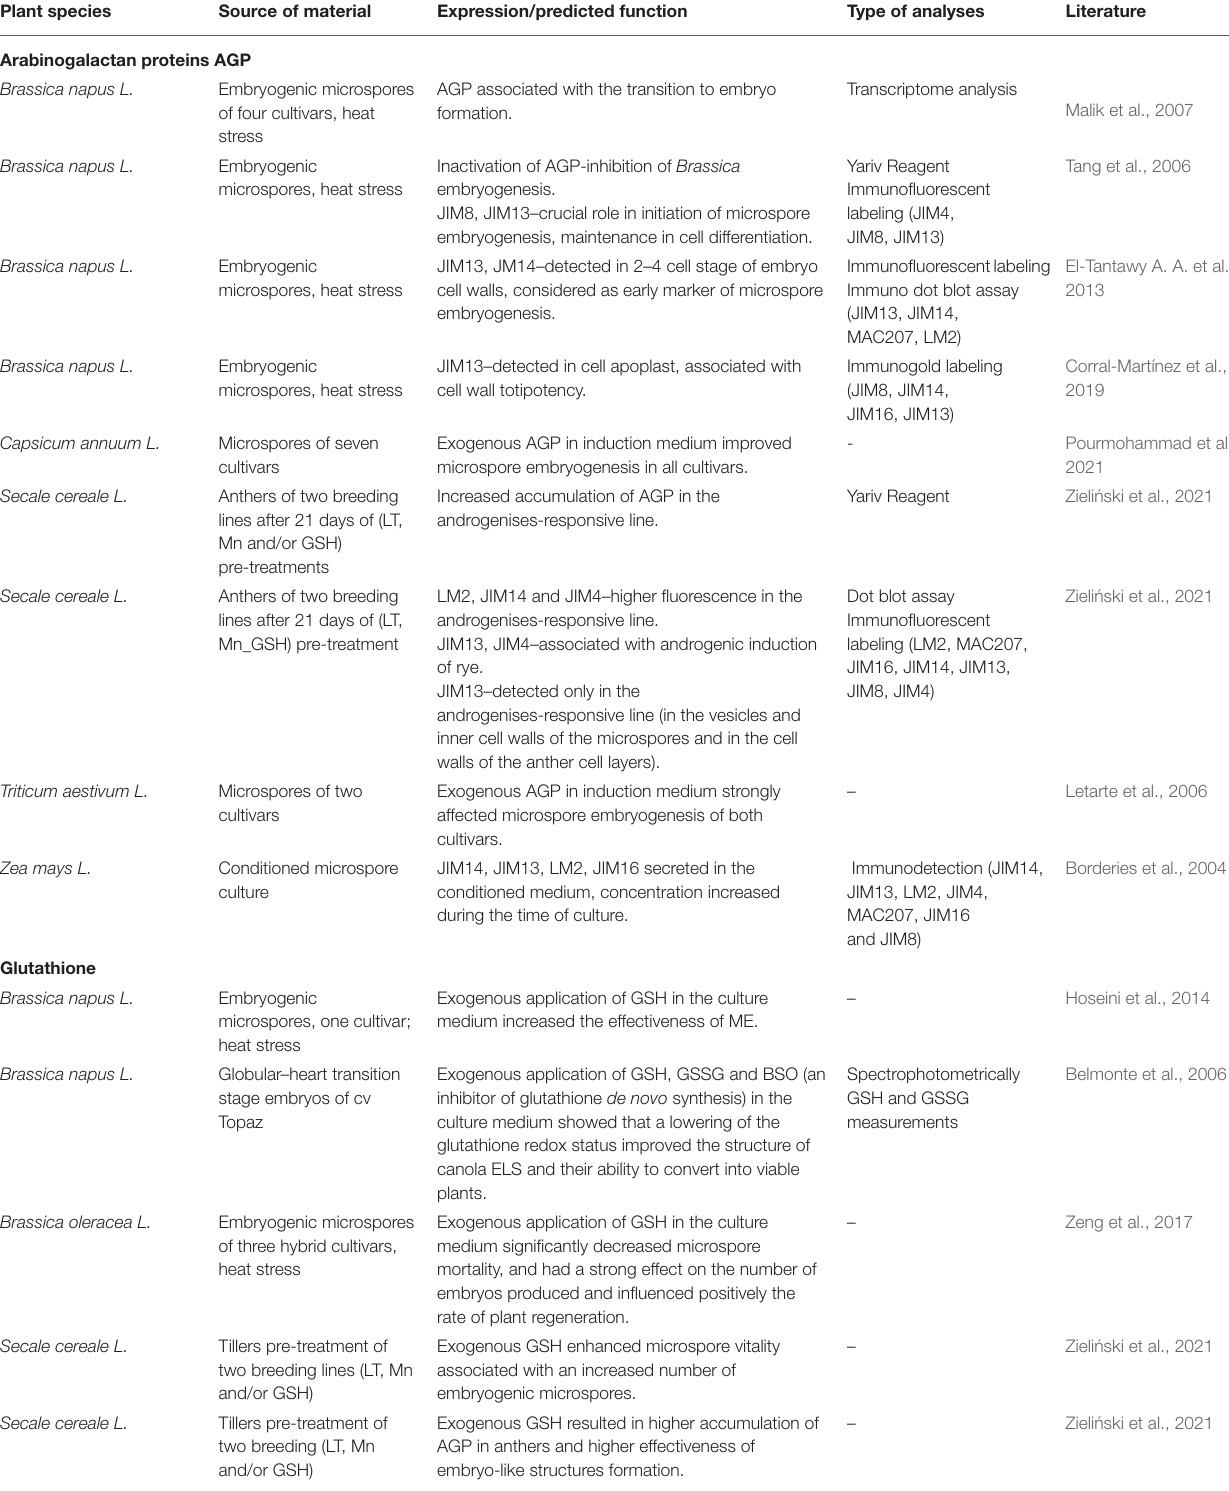
TABLE 1 | Proteins and peptides in microspore embryogenesis of crop